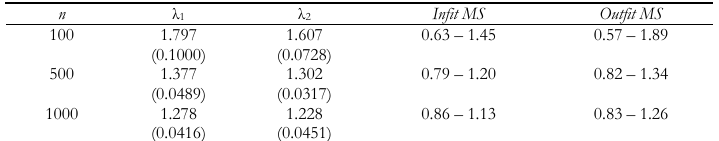
Reference values for the first two eigenvalues of PCA on Rasch residuals and the outfit and infit mean square